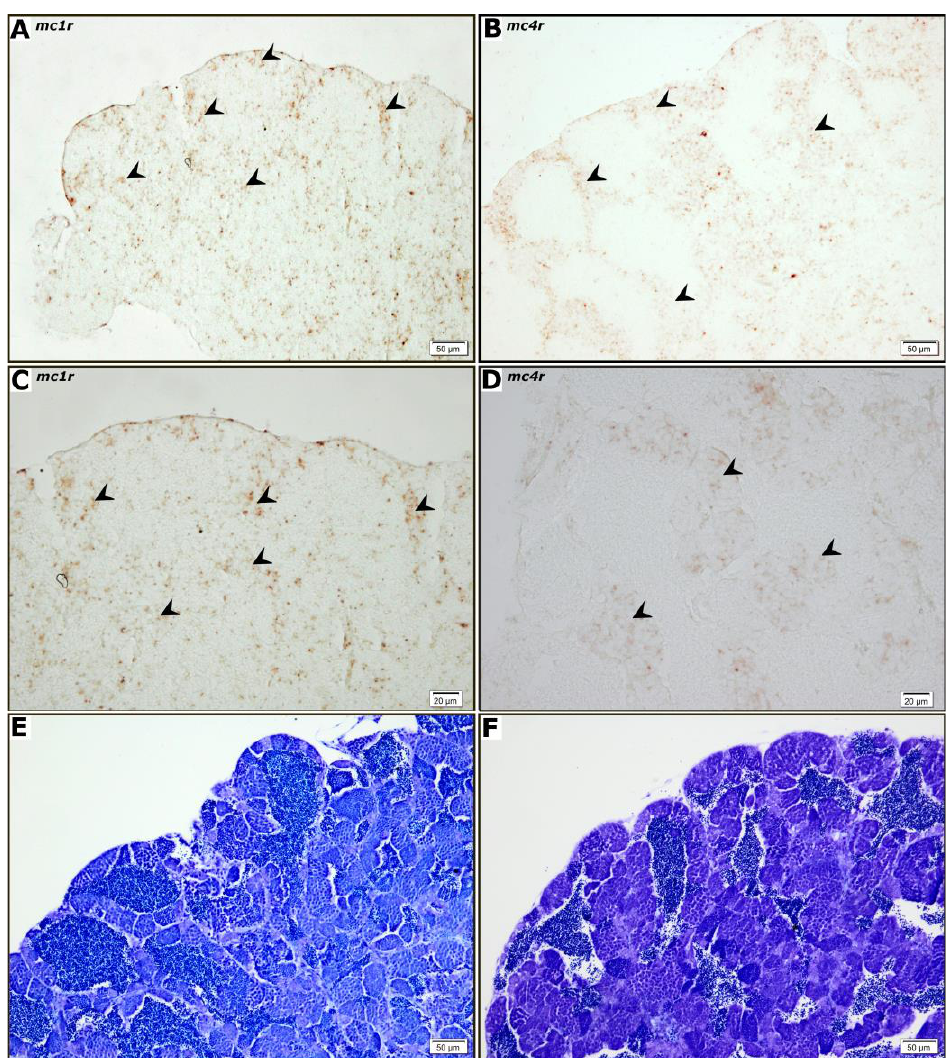
Figure 3. Localization of mcr1 and mcr4 transcripts expression in zebrafish testes by in situ hybridization. Panels ( A ) and ( B ) show mc1r and mc4r expression in germ cells, respectively. ( C ) and ( D ) are magnified views of ( A ) and ( B ) for detail. ( E ) and ( F ) are representative tissue sections of ( A ) and ( B ) stained with toluidine blue, respectively.